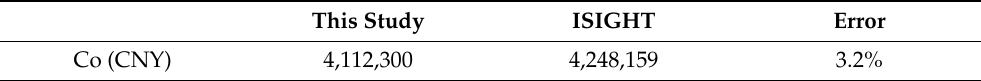
Table 1. Comparison of ISIGHT results and optimization results in this study.